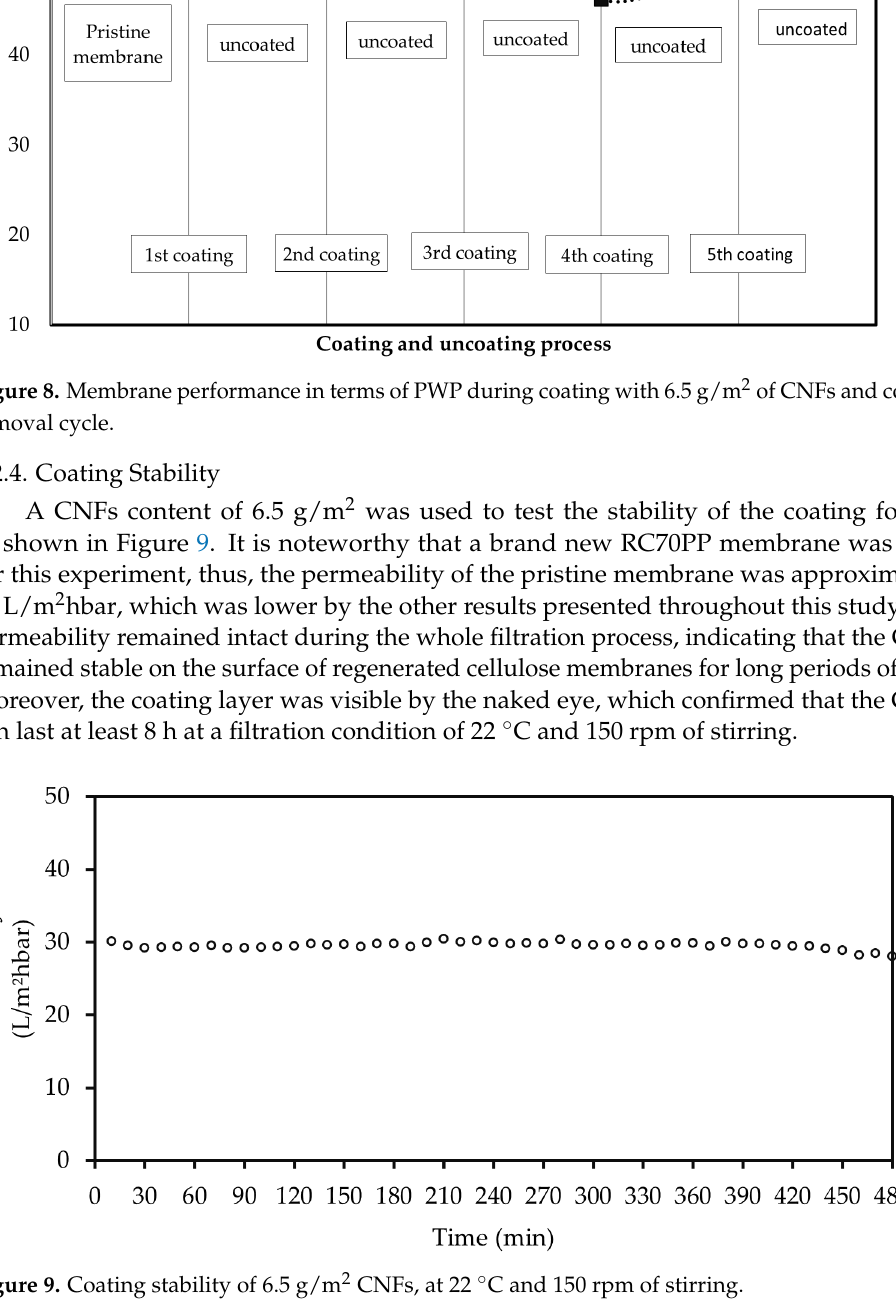
Figure 7. Ten-ppm MB solutions were filtrated by a pristine and coated UF membranes five times. Coating was removed and new coatings of CNFs (6.5 g/m 2 ) were built up again after each filtration of fresh dye solution.